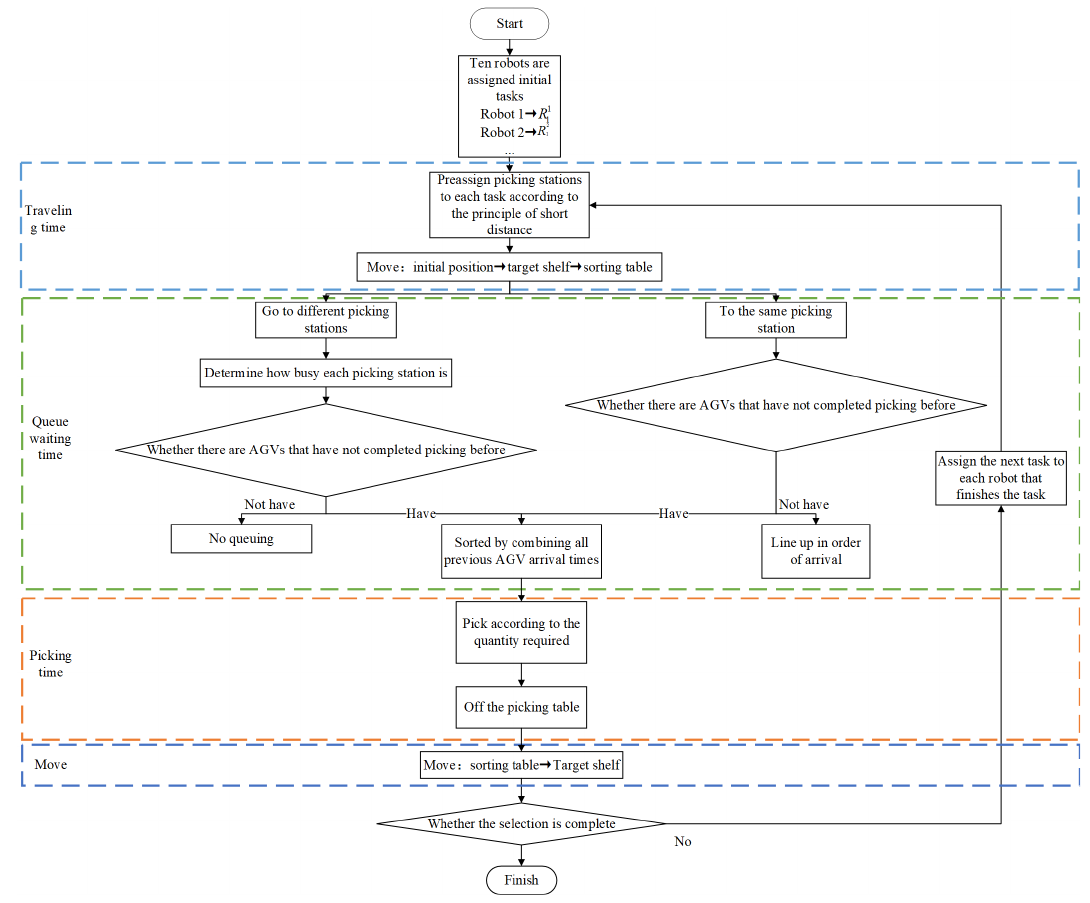
Figure 8. The process of AGV